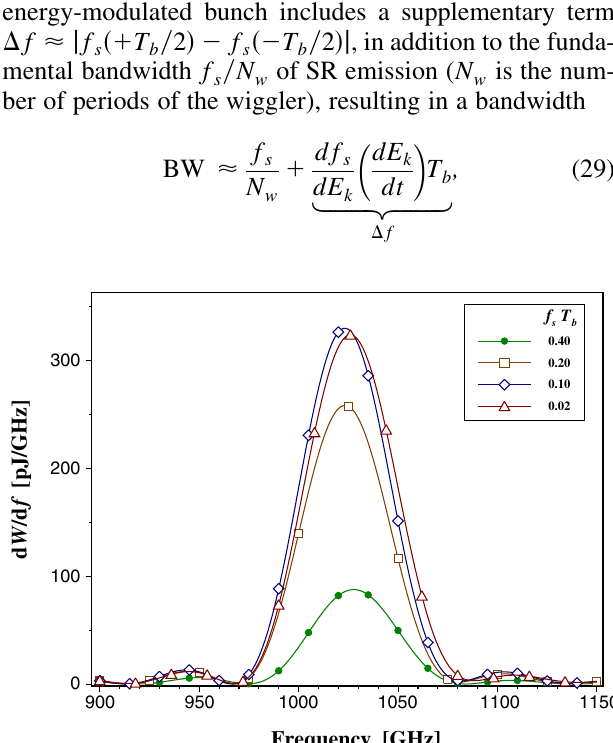
FIG. 3. (Color) Spectrum of radiation emitted by unmodulated Q (cid:4) 10 pC electron bunches.